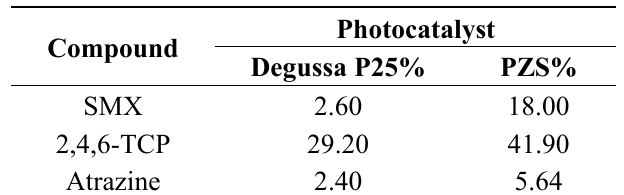
Table 1. Adsorption percentage of the different model compounds at initial concentrations of 50.0 mg/L on the surface of PZS and P25 after the dark period. SMX, sulfamethoxazole; 2,4,6-TCP, 2,4,6-trichlorophenol.